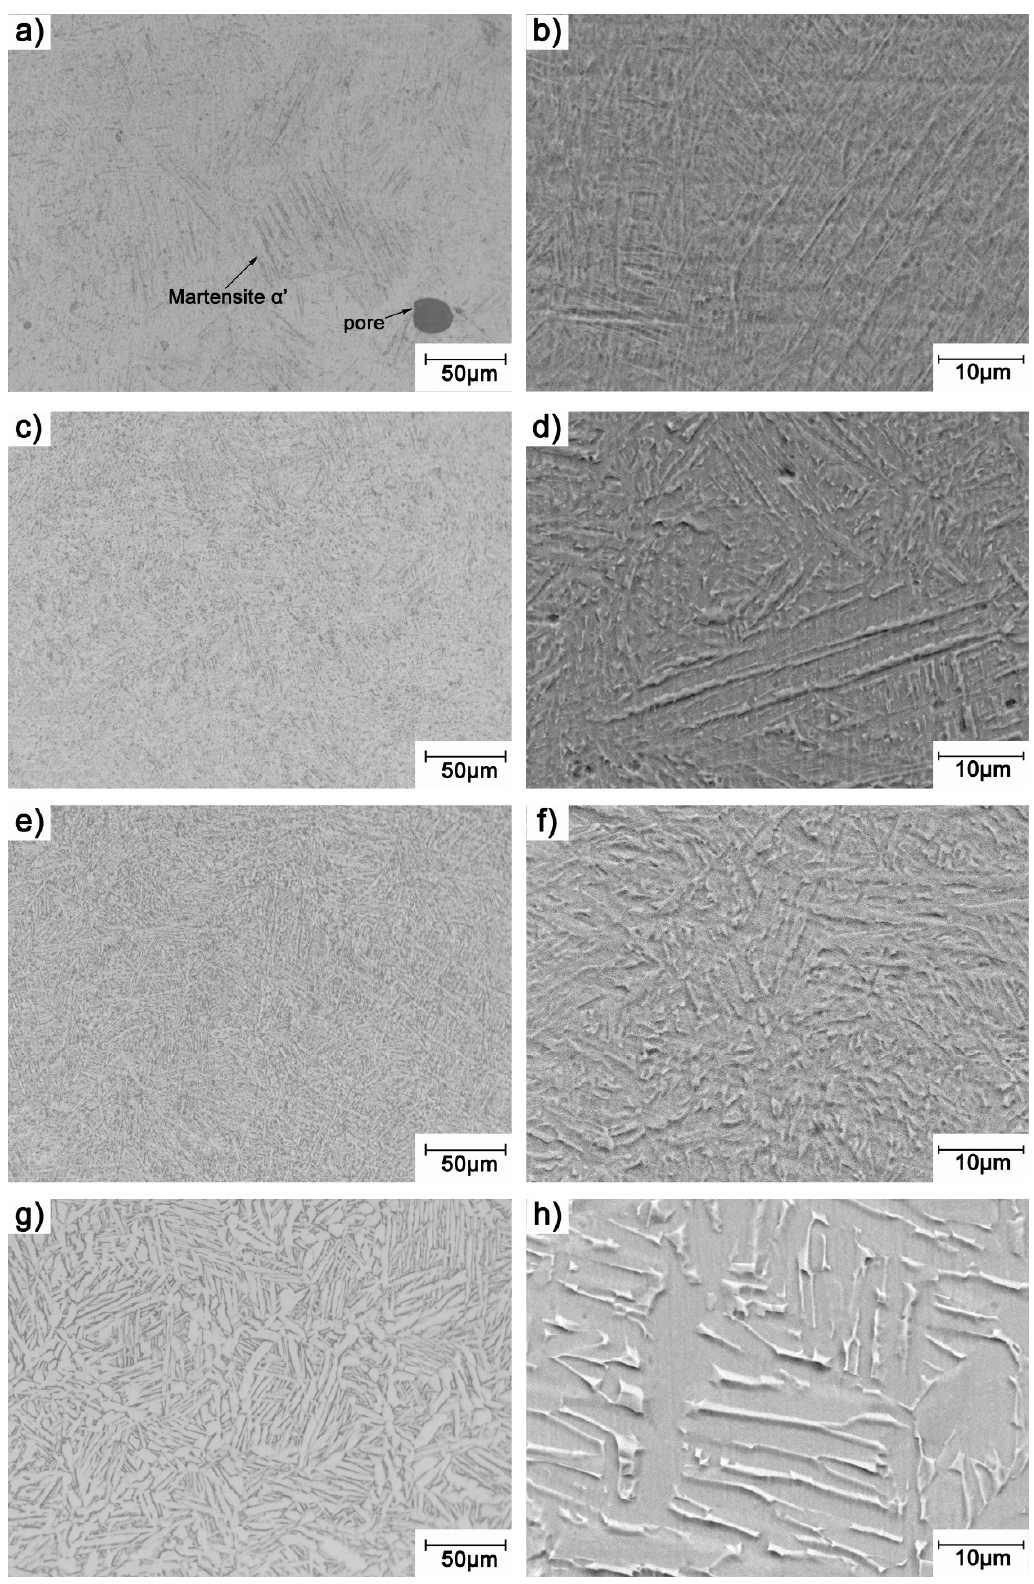
Figure 5. Microstructure of porous Ti64 before and after heat treatment: ( a ) as-built OM image; ( b ) as-built SEM image; ( c ) heat-treated at 750 °C OM image; ( d ) heat-treated at 750 °C SEM image; ( e ) heat-treated at 850 °C OM image; ( f ) heat-treated at 850 °C SEM image; ( g ) heat-treated at 950 °C OM image; ( h ) heat-treated at 950 °C SEM image.